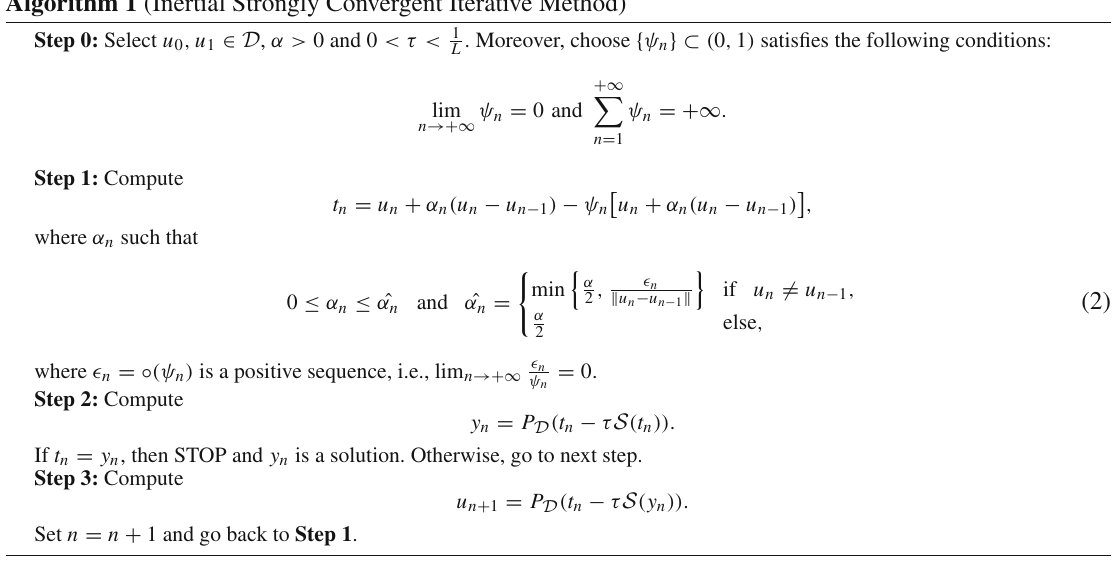
Algorithm 1 (Inertial Strongly Convergent Iterative